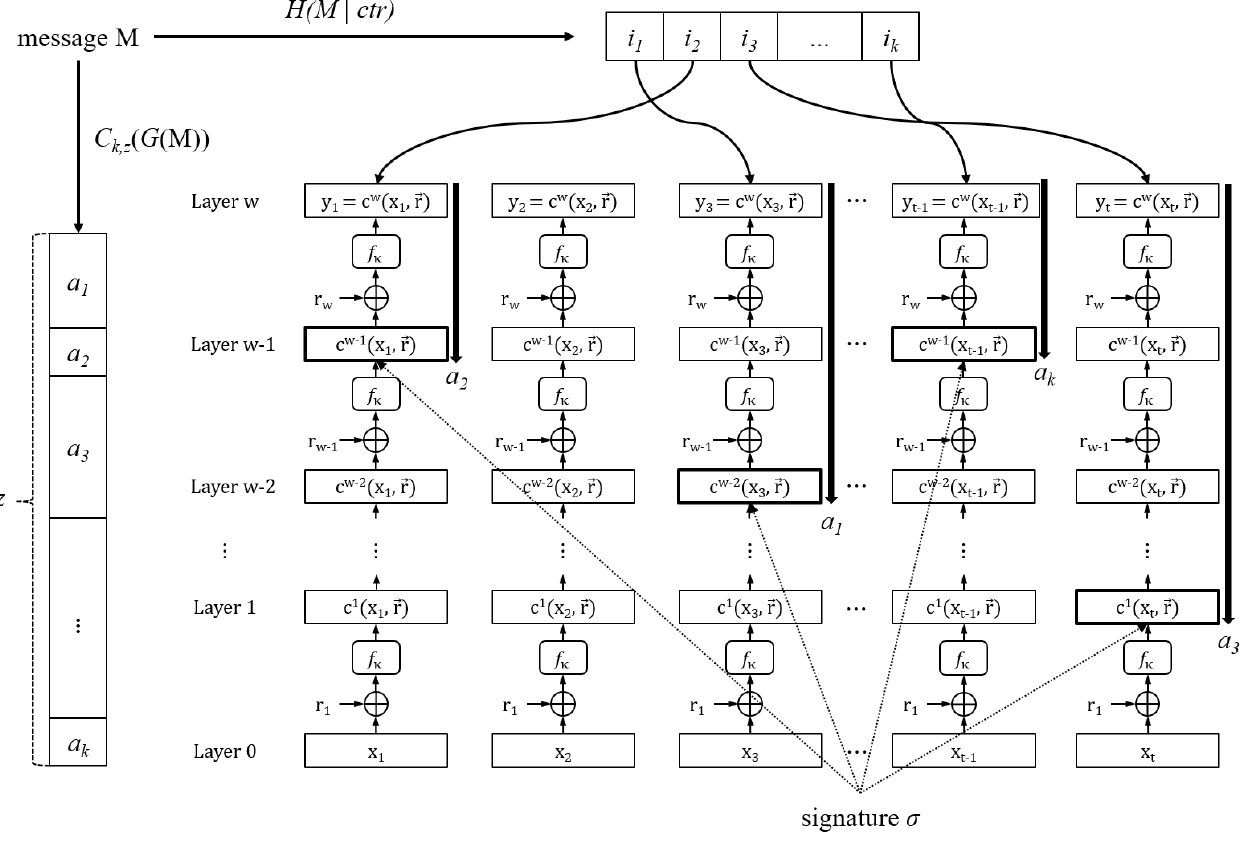
Figure 1. Signing of